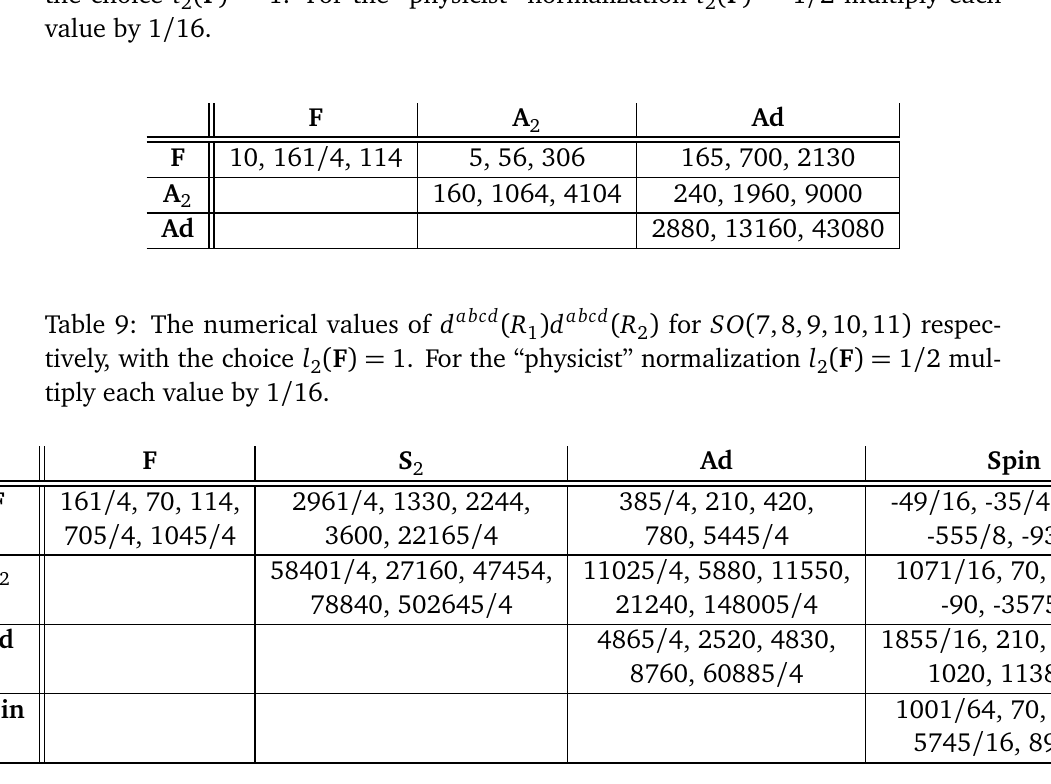
) d abcd ( R ) for Sp ( 4,6,8 ) respectively, with 1 2 ( F ) = 1 / 2 multiply each 2